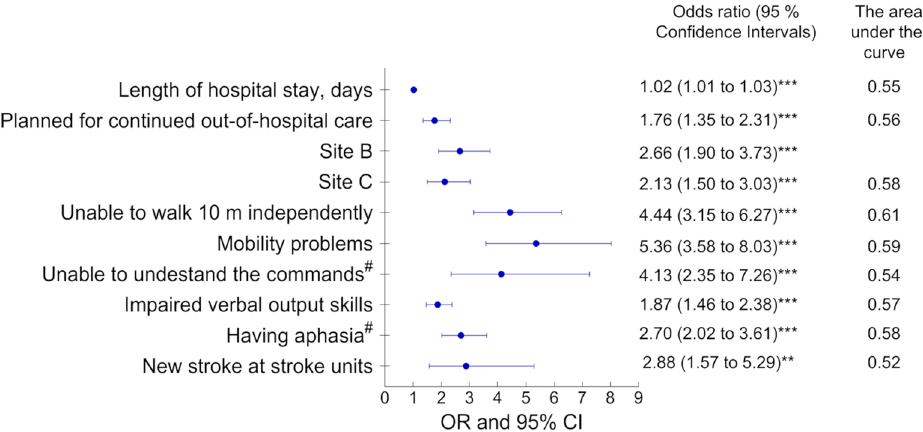
Figure 5. A forest plot showing the results of univariable binary logistic regression analyses explaining the barriers to cognitive screening in 1120 patients with first-ever stroke. Site B provides reperfusion